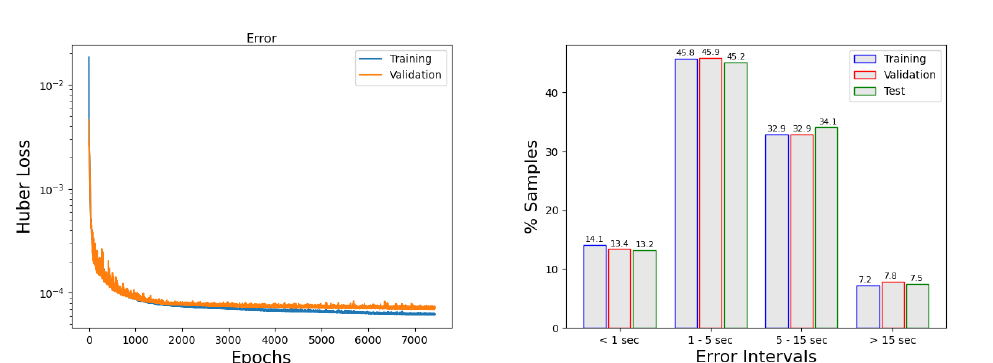
Figure A3. Train and validation error during training ( left ) and percentage of predictions in certain error intervals in the arrival times problem ( right ) with 12 forecast points. Table A3. Mean and maximum absolute errors for the predicted arrival times in 12 forecast